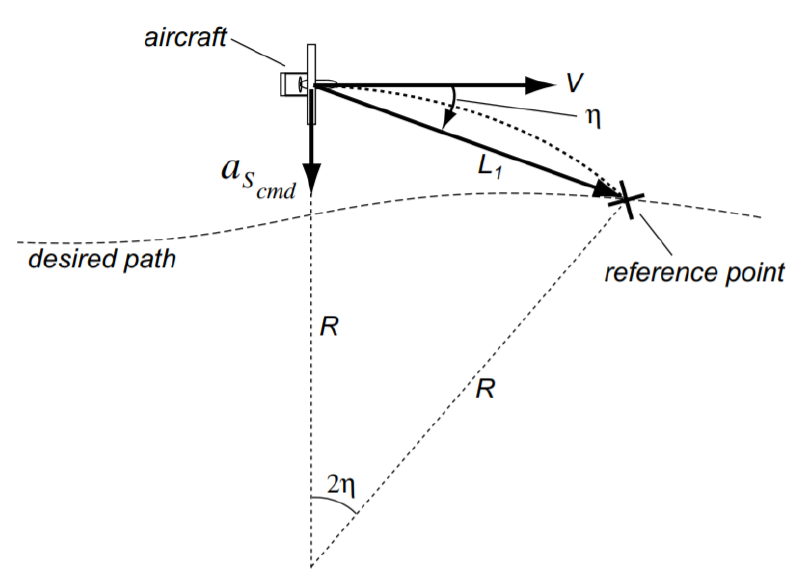
Figure 4. Guidance logic schematic [26].